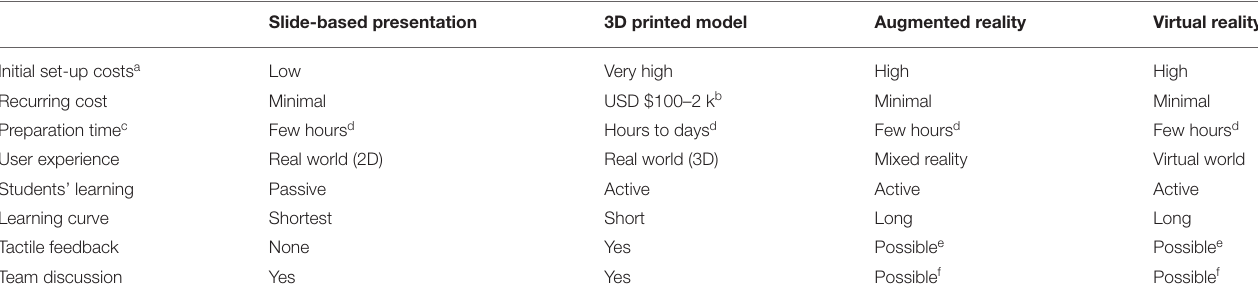
TABLE 1 | Comparison between slide-based presentation, 3D printed model, augmented reality, and virtual